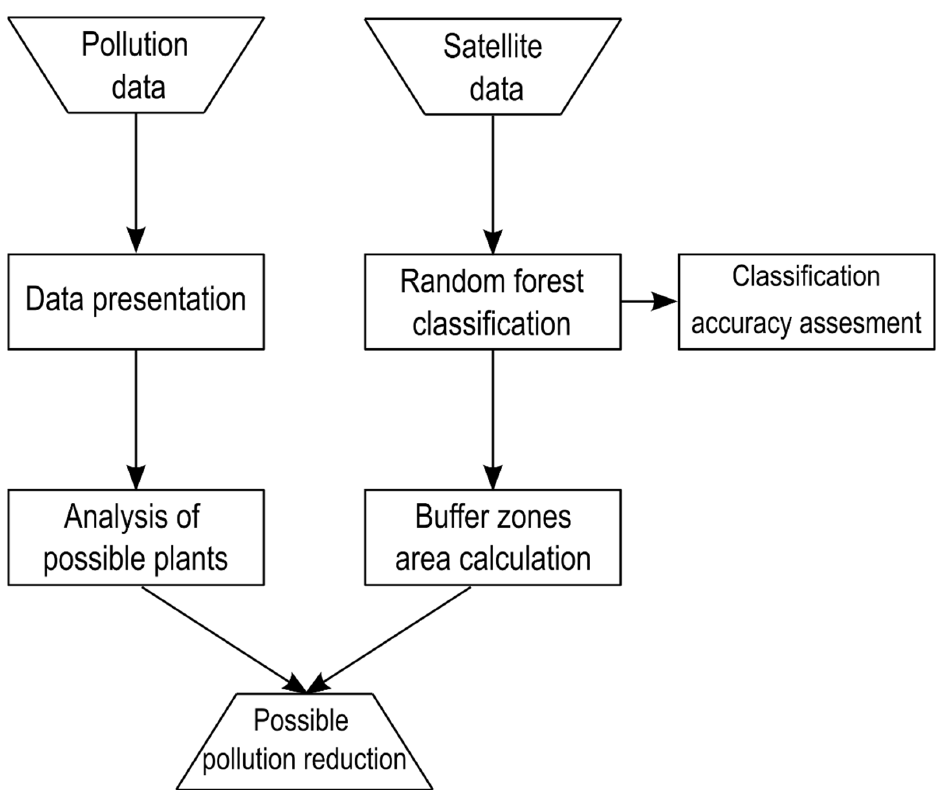
Figure 3. Methodology flowchart .